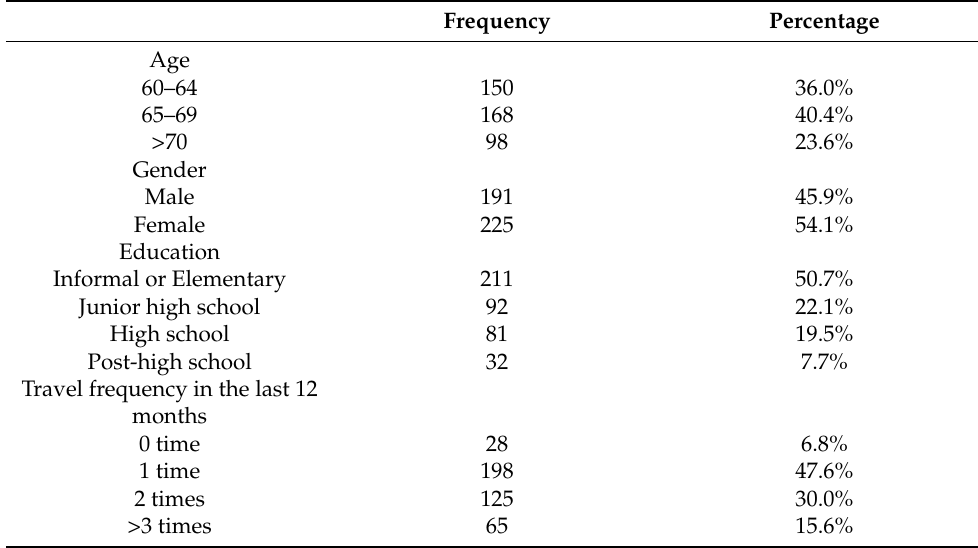
Table 2. Summary of the demographic characteristics ( n = 416).